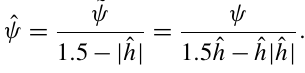
Figure 6. The scatter plot of the realistic conditions of the normal- ized sweep angle ˜ ψ against the equivalent relative position ˆ h in the first